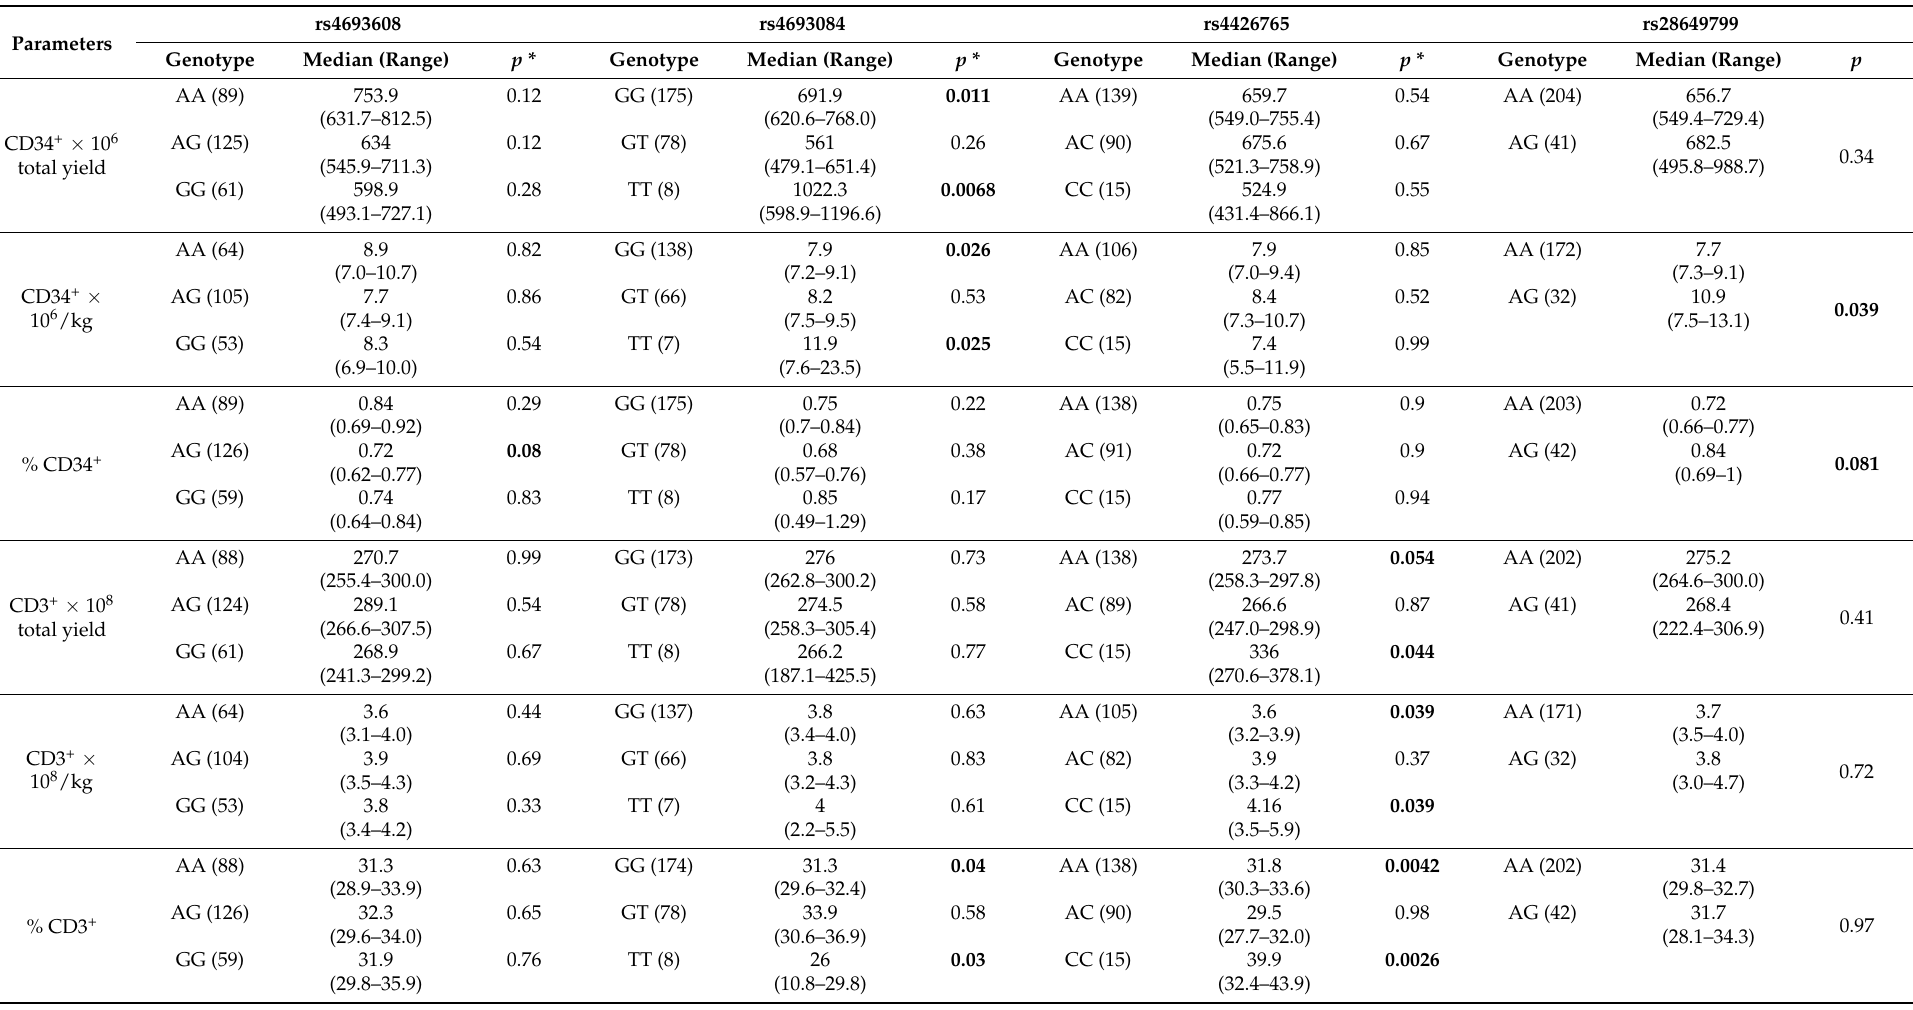
Table 7. Association analysis between enhancer and insulator HPSE gene SNPs and mobilization parameters after granulocyte colony-stimulating factor (G-CSF) administration to healthy